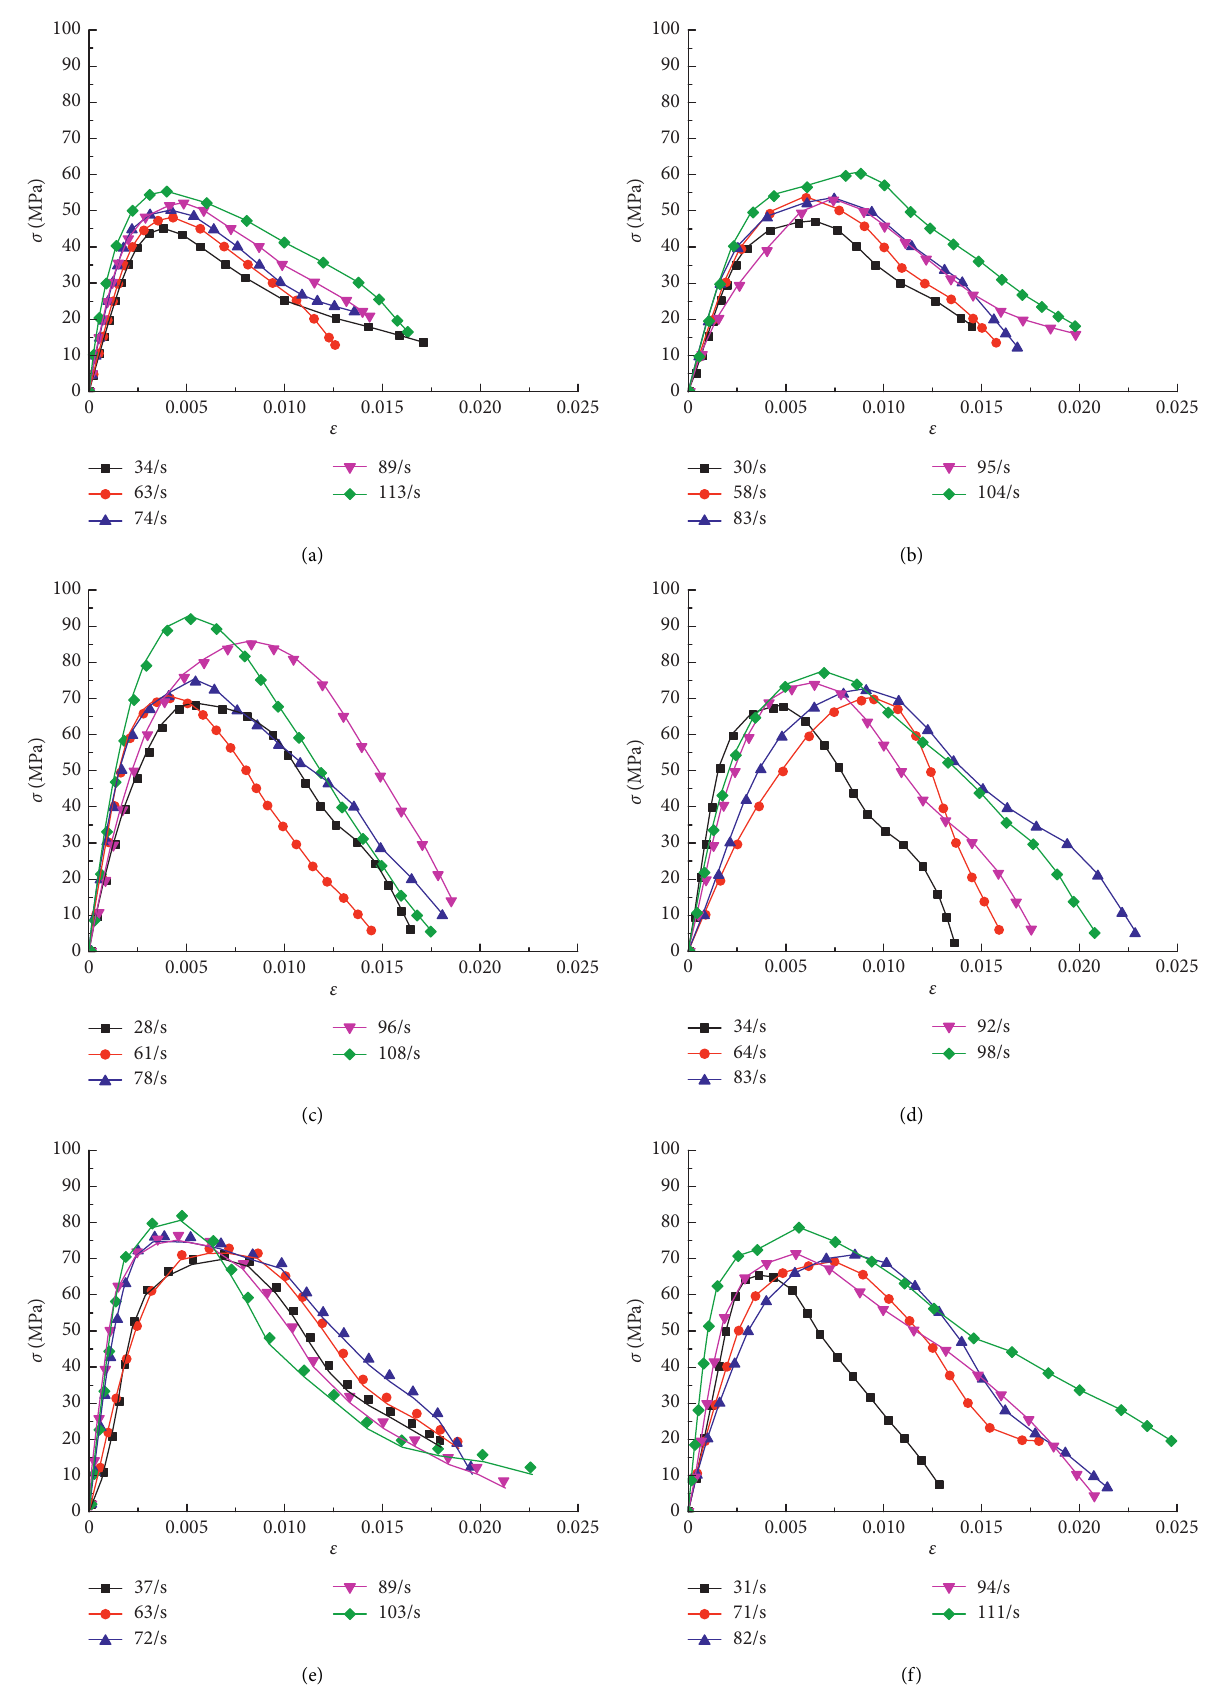
Figure 5: Dynamic stress-strain curves of HPFRC under different strain rates: (a) A1, (b) A2, (c) A3, (d) A4, (e) A5, and (f)